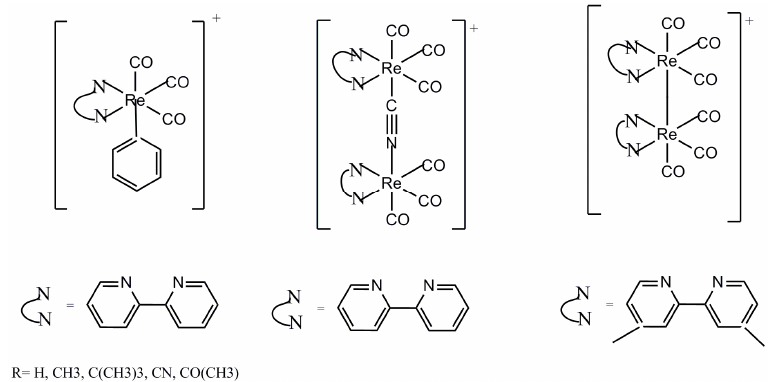
Figure 21. Some examples of Re(I) mononuclear and binuclear complexes with pyridyl ligands, which behave as molecular photocatalysts in the photoactivated reduction of CO 2 ([169,183] and references therein).